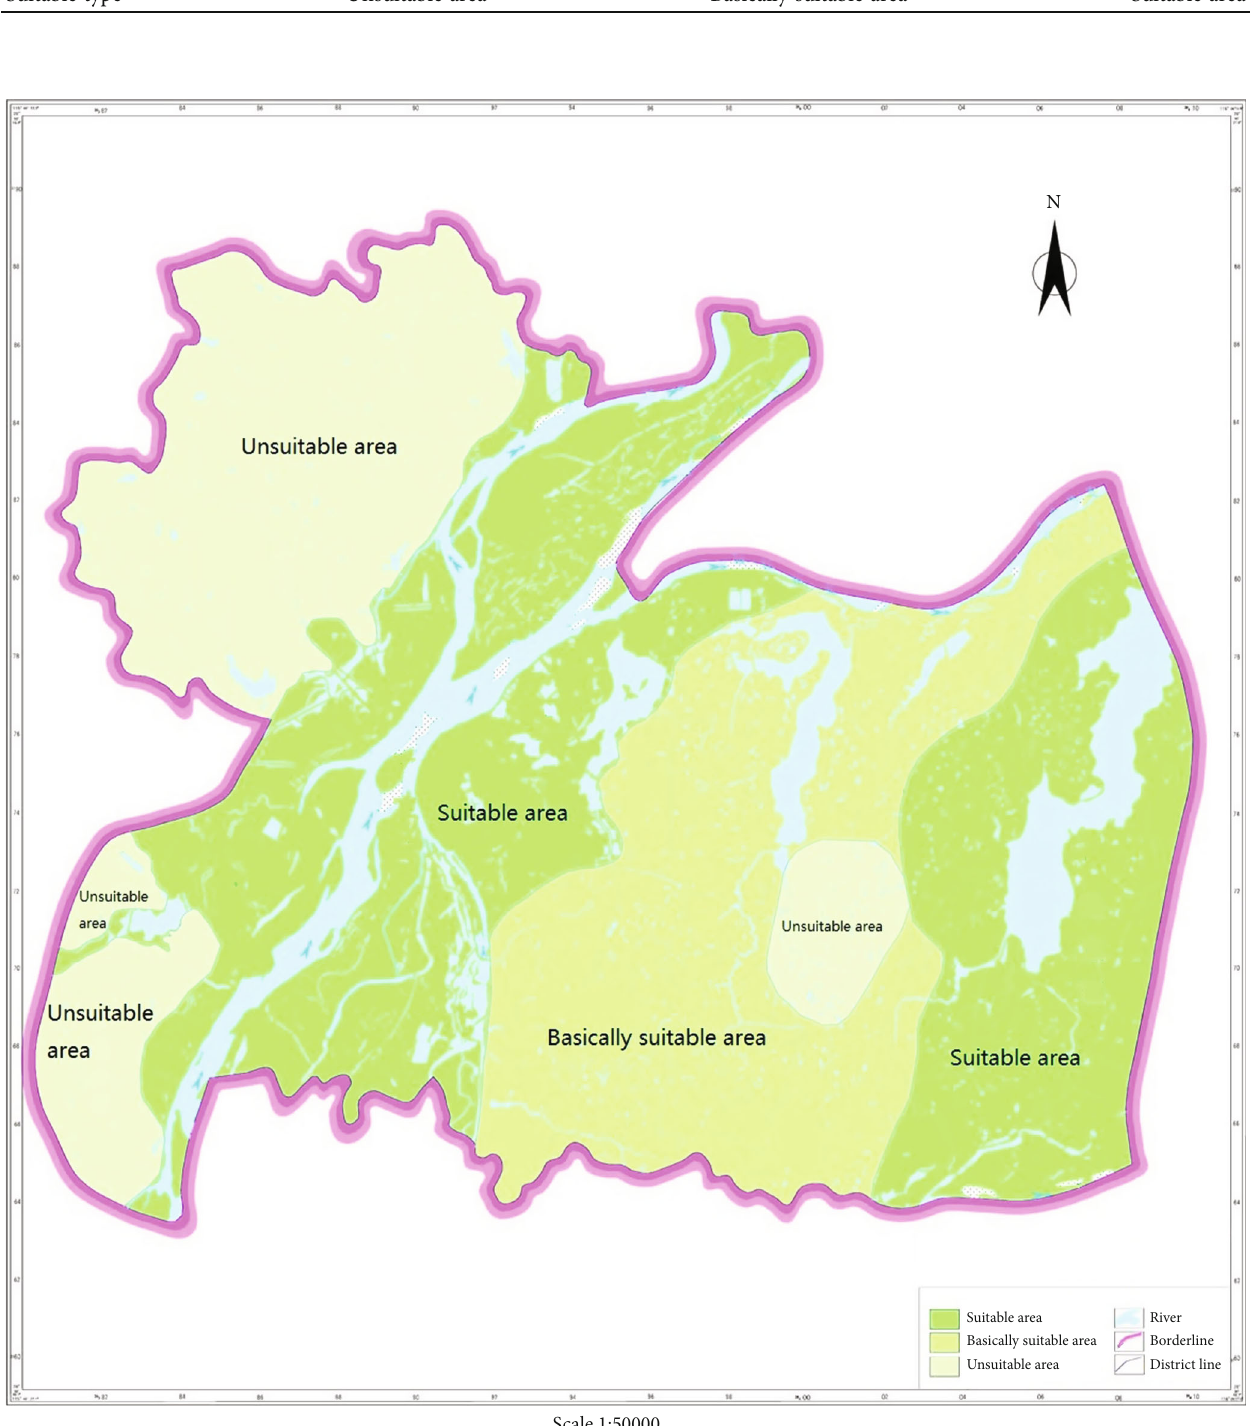
Figure 9: Suitability zoning map of the groundwater ground source heat pump.